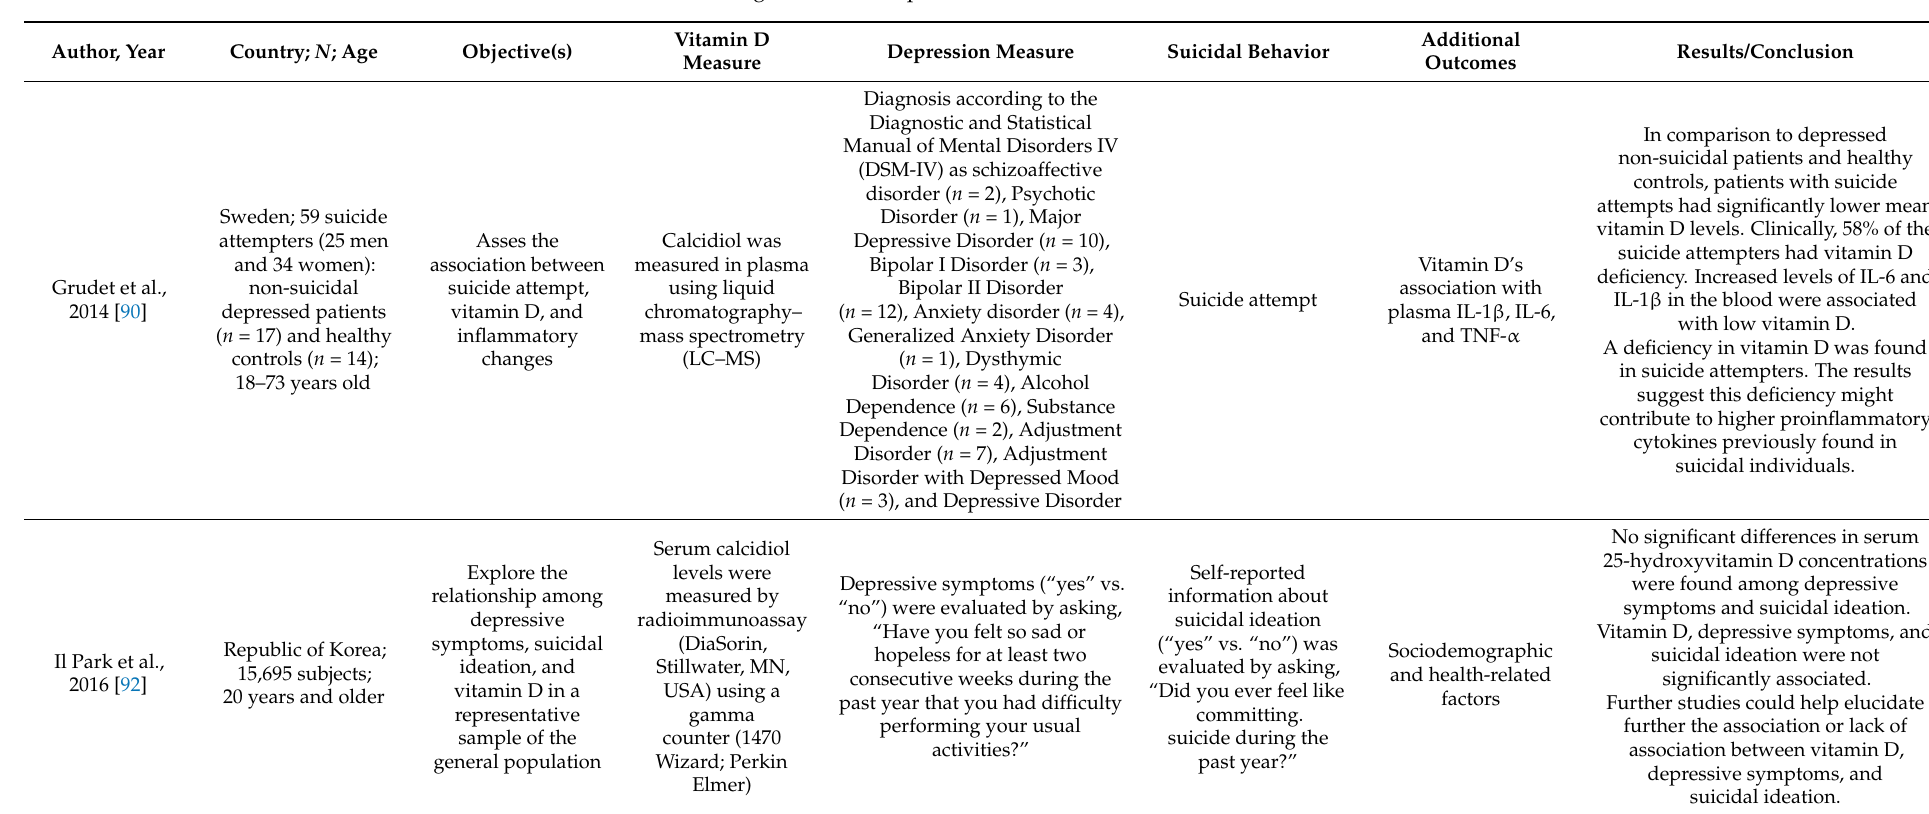
Table 1. Observational studies associating vitamin D, depression, and suicidal